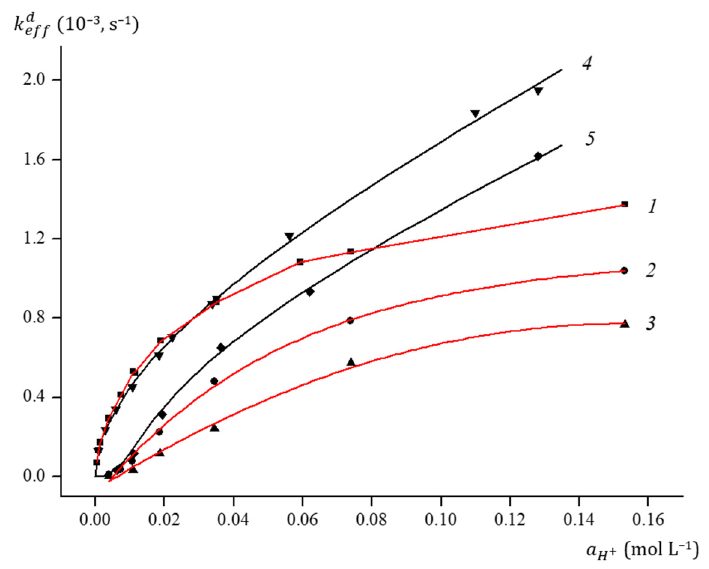
Figure 13. Plots of the k d values for clathrochelates FeOx 3 (BCH 3 ) 2 ( 5 , this work, shown in red, at the concentrations of methylboronic acid equal to 0 ( 1 ), 3.06 × 10 − 2 ( 2 ) and 6.38 × 10 − 2 ( 3 ) mol L − 1 ) and FeNx 3 (BCH 3 ) 2 ( 4 , shown in black, at the concentrations of methylboronic acid equal to 0 (4) and 1.53 × 10 − 1 (5) mol L − 1 ) versus the activity of H + ions. Adapted from ref. [6].